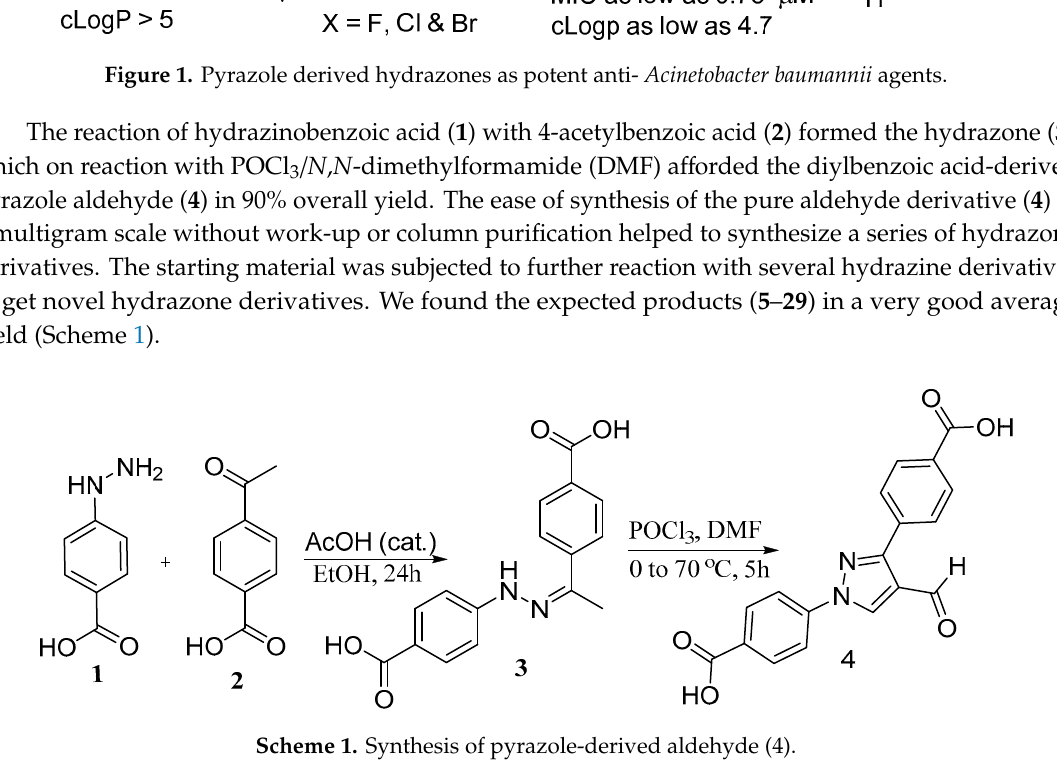
Scheme 1: Synthesis of pyrazole-derived aldehyde